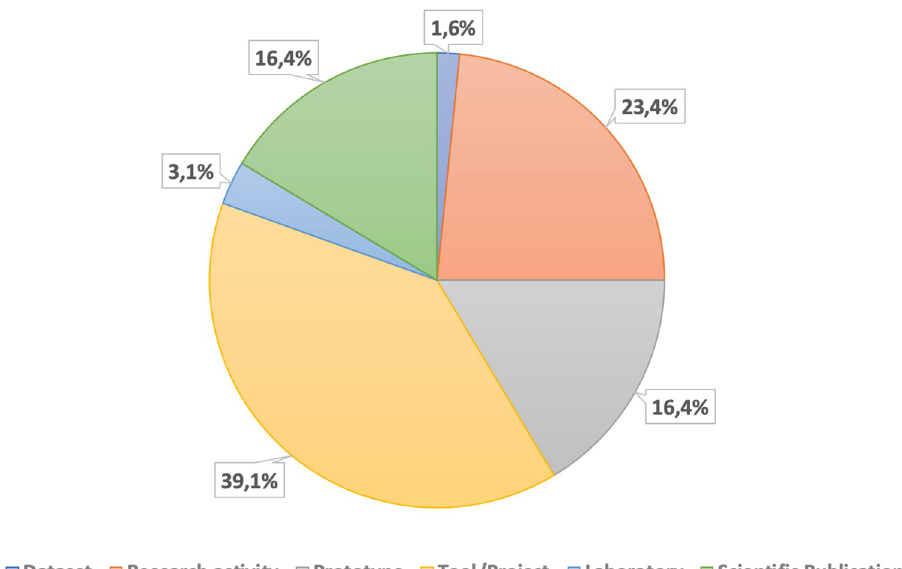
Fig 2. Statistics on the types of the surveyed initiatives.